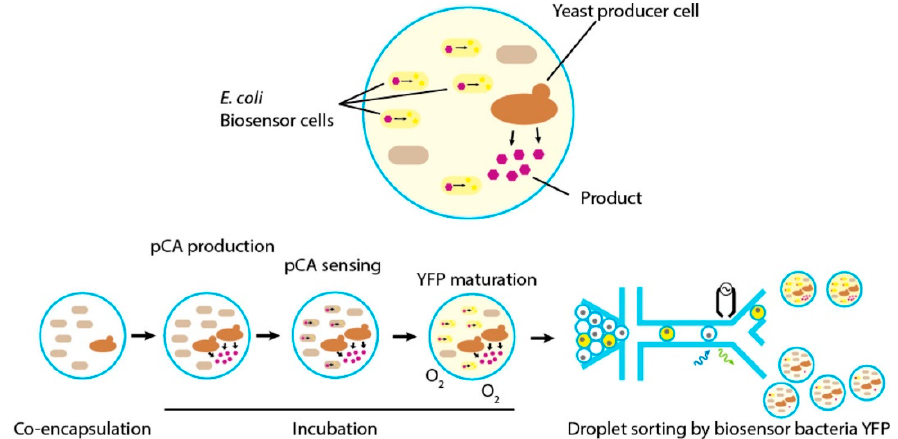
Figure 19. Schematic representation of the mechanism of the E. Coli biosensor for detection of p-coumaric acid producing yeast cells in picoliter droplets through YFP fluorescence detection. Reprinted with permission from ref. [146], copyright 2017, American Chemical Society.